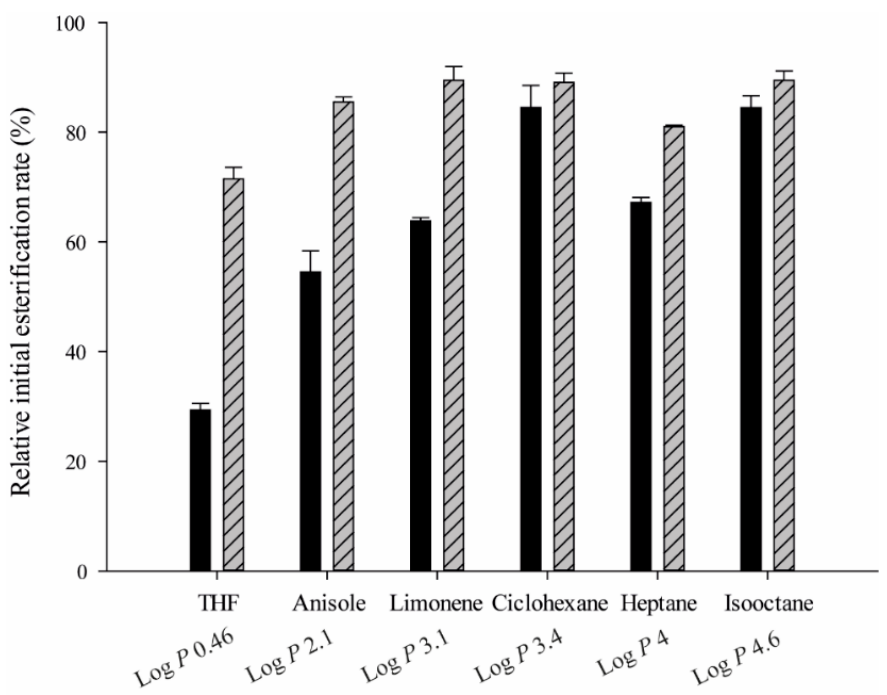
Figure 2. Relative initial reaction rate (%) of ethyl butyrate synthesis after incubation of the biocat- alysts for 24 h in the following solvents: tetrahydrofuran (THF), anisole, limonene, cyclohexane, heptane and isooctane. The Log p values for each solvent are shown under its name. EB-rROL (black). EB-proROL (striped grey). The initial reaction rate for each non-incubated biocatalyst was taken to be 100%.